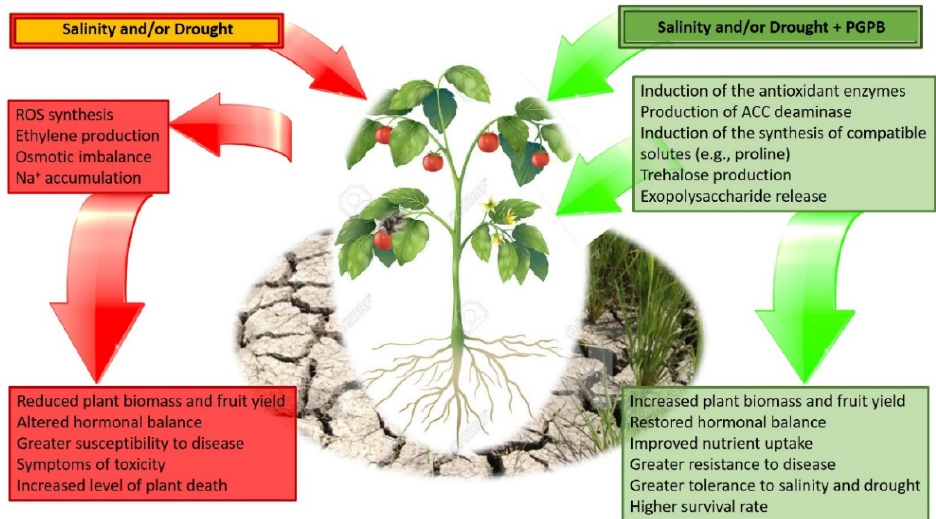
Figure 1. Schematic overview of the consequences of salt and drought stress on plants and the functioning of PGPBs supporting plant growth in these harsh environmental conditions.